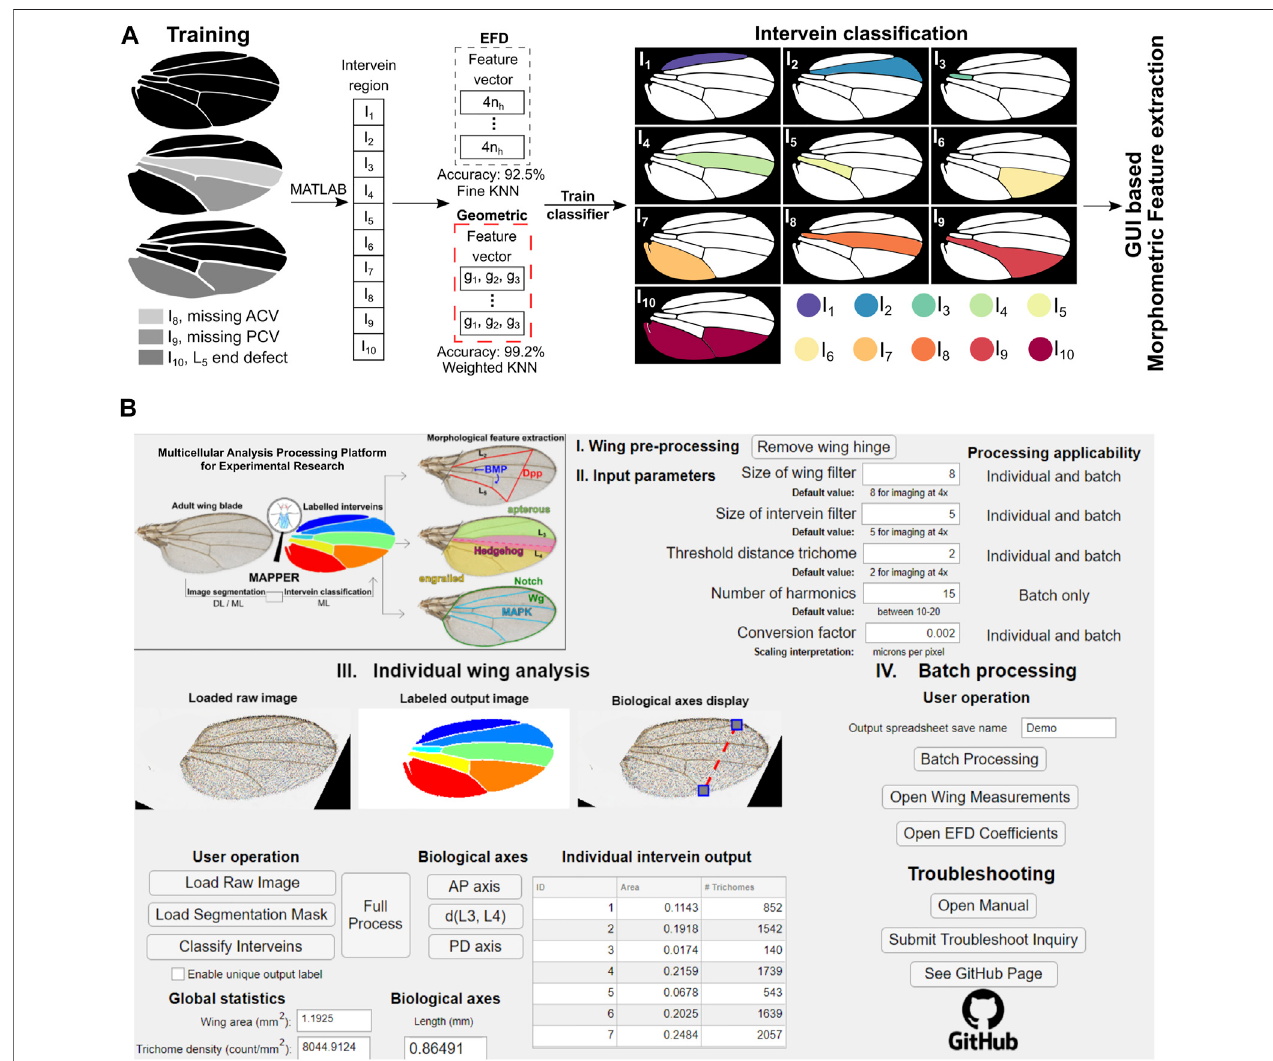
FIGURE2| MAPPERautomatesclassi fi cationandextractionofahigh( > 100)dimensionalmorphologicalfeatureset. (A) Duringtraining,individualinterveinregions weremanuallylabelledusingtheMATLAB ’ simagelabelerapp.EFDfeaturesalongwiththegeometricfeatureswereextractedfromthelabelledinterveinregionstotraina machine learning (ML)-based classi fi er. This trained model then identi fi es the intervein regions based on the input binary mask and the associated features of each intervein region. Edge cases of anterior cross vein (ACV), posterior cross vein (PCV), and marginal L 5 defects were included in the analysis. (B) Image of the MAPPERapplicationinterface.TheMAPPERapplicationsupportsbothindividual(III)andbatch(IV)processingofimagedatasetsbasedoninputparameters(II)speci fi c to a user ’ s imaging